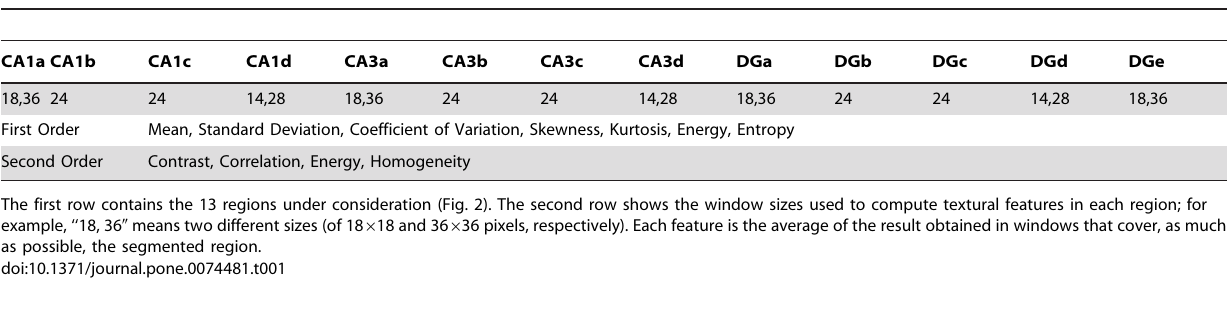
Table 1. Different features used for the